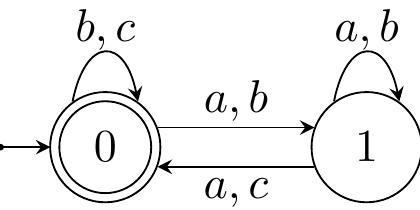
Figure 1. An inferred non-deterministic finite automaton